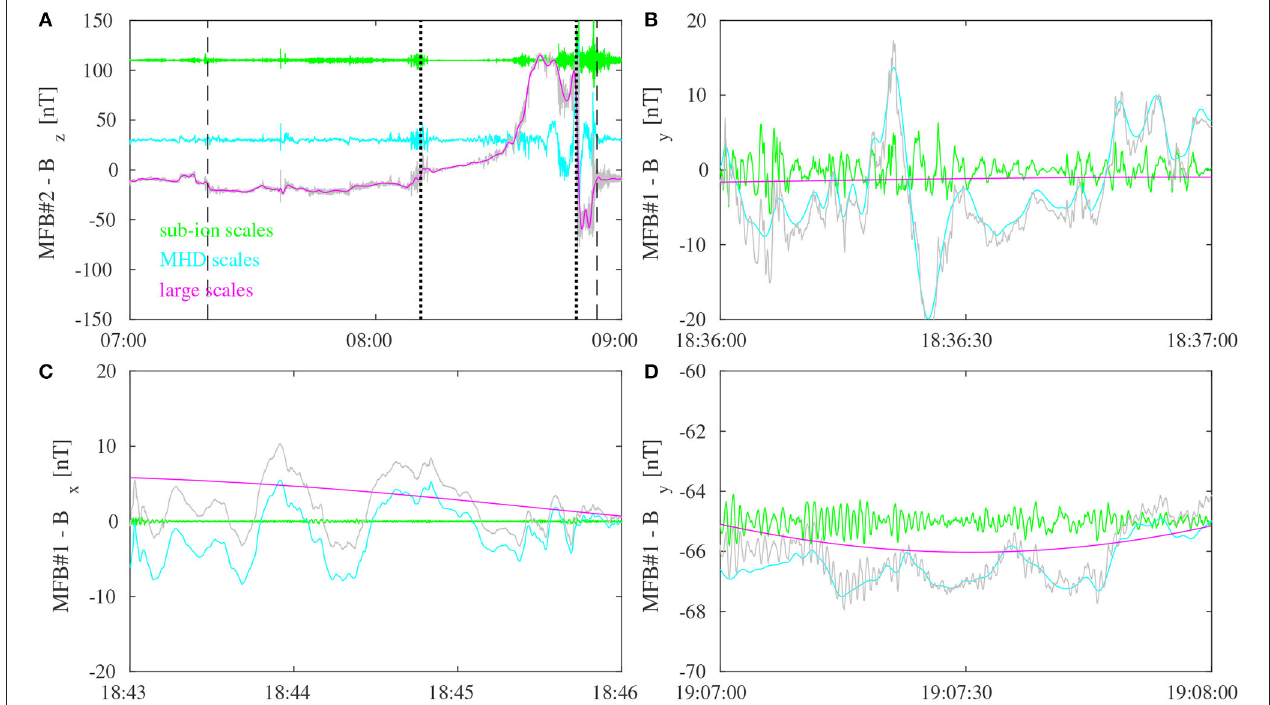
FIGURE 5 | The comparison between the original time series (gray lines) and the different reconstructions (colored lines) for selected magnetic field components during some selected intervals corresponding to (A) the near-Hermean electromagnetic environment, (B) a flux transfer event (FTE), (C) Kelvin-Helmholtz vortex-like structures, and (D) ULF waves. Green, cyan, and magenta lines refer to the kinetic, MHD, and large-scale ranges, respectively. The vertical dashed and dotted lines in (A) refer to the bow shock and magnetopause crossings, respectively. An offset is applied to the sub-ion and MHD reconstructions for visual purposes in (A,D)